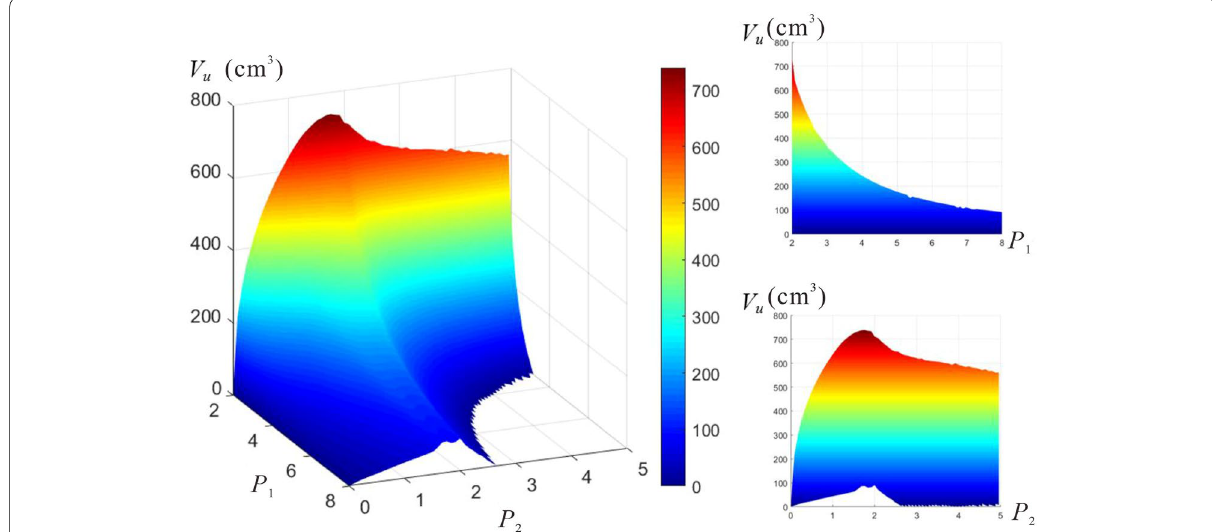
Figure 13 Volume of the workspace of the under-actuated finger